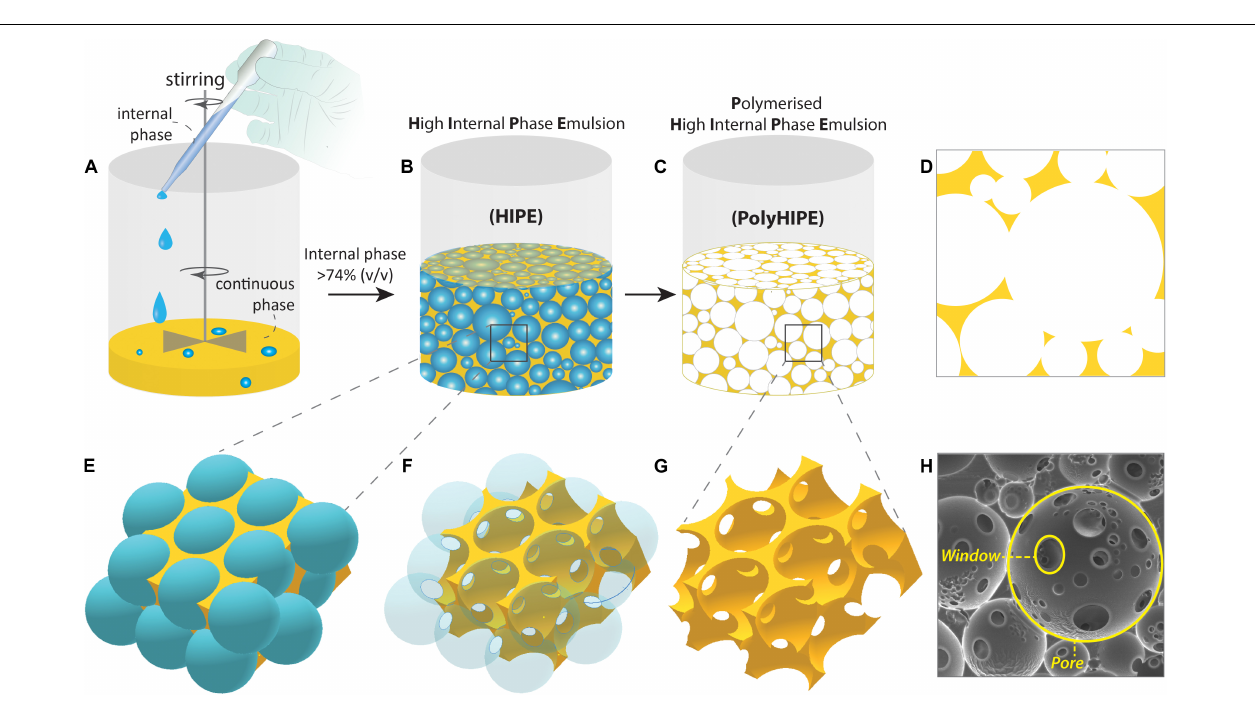
FIGURE 2 | Fabrication steps of the Polymerised High Internal Phase Emulsion (PolyHIPE). (A,B) The gradual addition of the internal phase into the continuous phase while the system is mixed, (C) polymerisation of the high internal phase emulsion (HIPE), (D) 2D projection of PolyHIPE, (E–G) the formation of the pores and windows, and (H) scanning electron microscope image of the